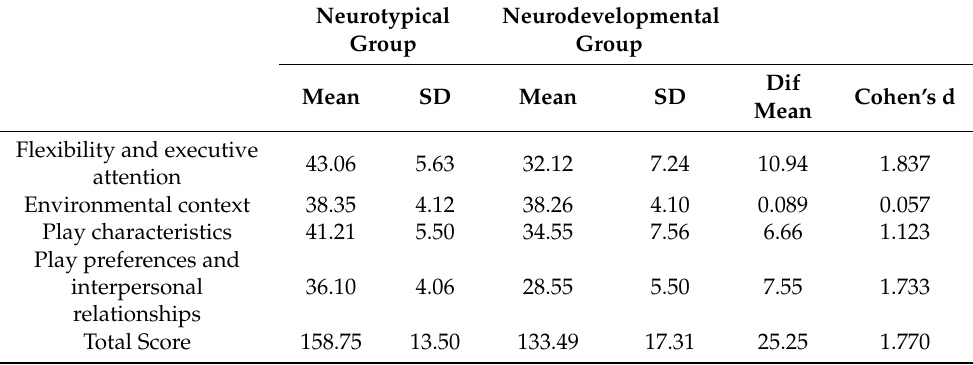
Table 5. Mean scores in neurotypical and neurodevelopmental